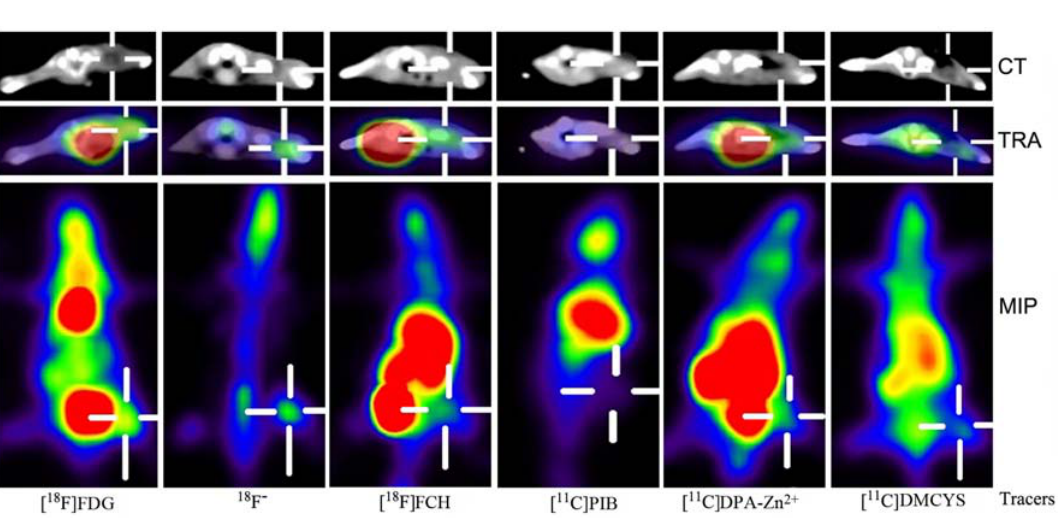
Figure 1. The transverse (TRA) CT and PET/CT fusion images, and the coronal maximum intensity projection (MIP) images in IM (cross-shaped lines) with multiple tracers ([ 18 F]FDG, 18 F − , [ 18 F]FCH, [ 11 C]PIB, [ 11 C]DPA-Zn 2+ and [ 11 C]DMCYS) at 60 min